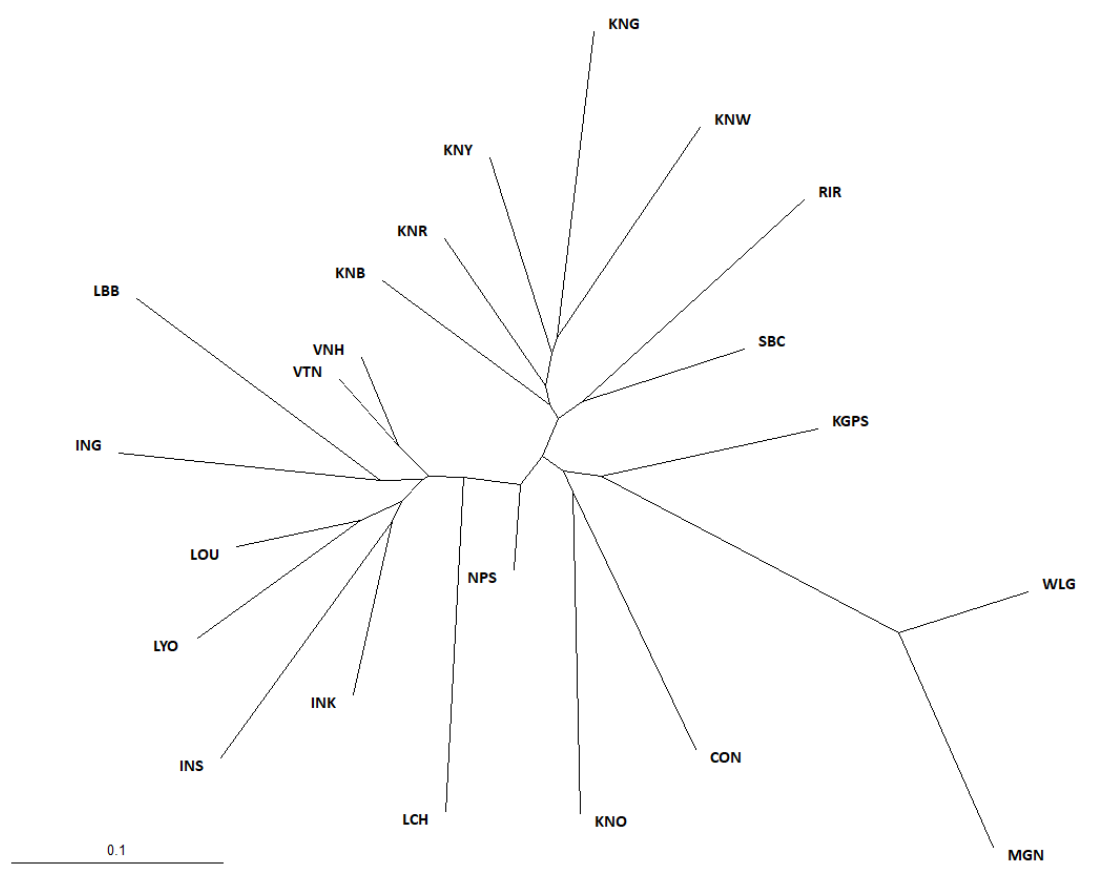
Figure 1. Neighbor-joining phylogenetic tree showing genetic relationships among 22 chicken breeds based on D among 22 chicken breeds. RIR, Rhode Island Red; WLG, White Leghorn; CON, Cornish; KNG, Korean Grayish-brown; KNB, Korean Black; KNR, Korean Reddish-brown; KNW, Korean White; KNY, Korean Yellowish-brown; KNO, Korean Ogye; MGN, Mongolian Nuthiin bor; INK, Indonesian KUB; INS, Indonesian Sensi; ING, Indonesian Gaok; KGPS, Kyrzyzstani GPS-H; LYO, Laotian York; LCH, Lotian Chae; LBB, Laotian Black Bone; LOU, Latotian Ou; NPS, Nepalese Sakini; SBC, Sri Lankan